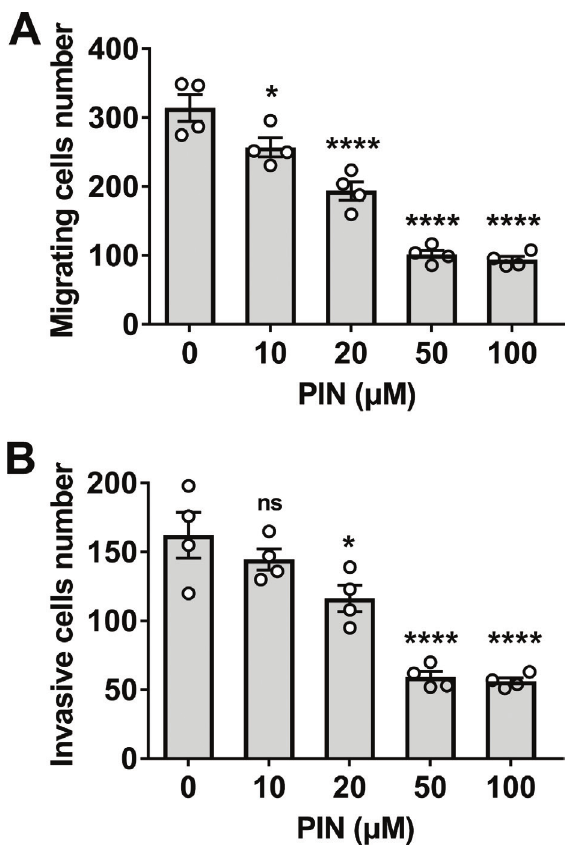
Fig. 1. Effect of pinocembrin on the migration and inva- sion of A549 cells. A549 cells were treated with pinocembrin (PIN) at the indicated concentration. Cell migration (A) and invasion (B) were analyzed. Migrating and invasive cells were stained with hematoxylin and counted. Four wells per group. The significant difference vs control group was analyzed using one-way ANOVA test. Data represents Mean ± SEM. * P < 0.05, **** P < 0.0001, ns, not